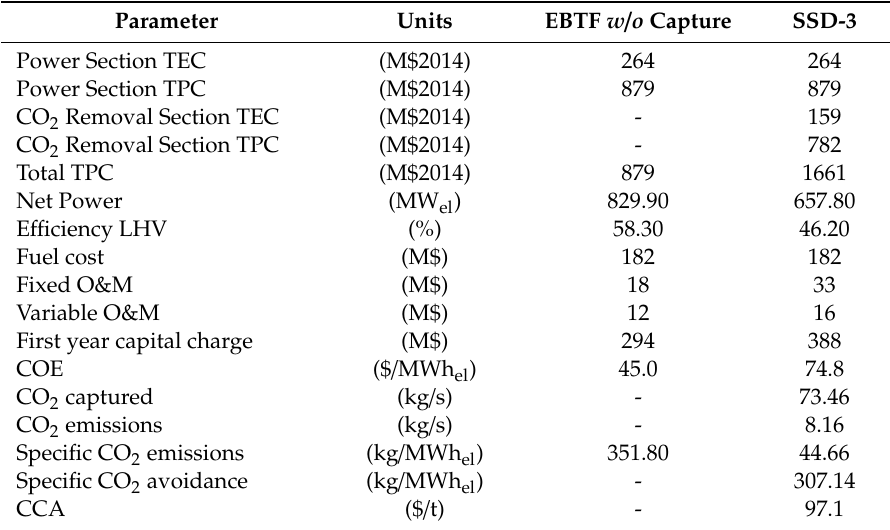
Table 22. SSD economic